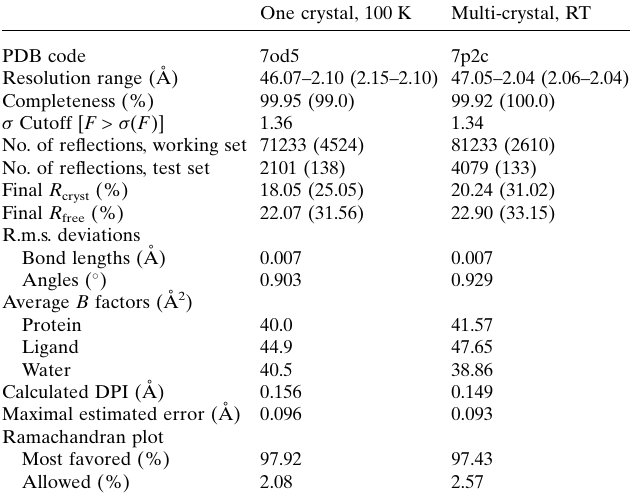
Table 2 Structure solution and refinement for F(M197)H RC. Values in parentheses are for the highest resolution shell.